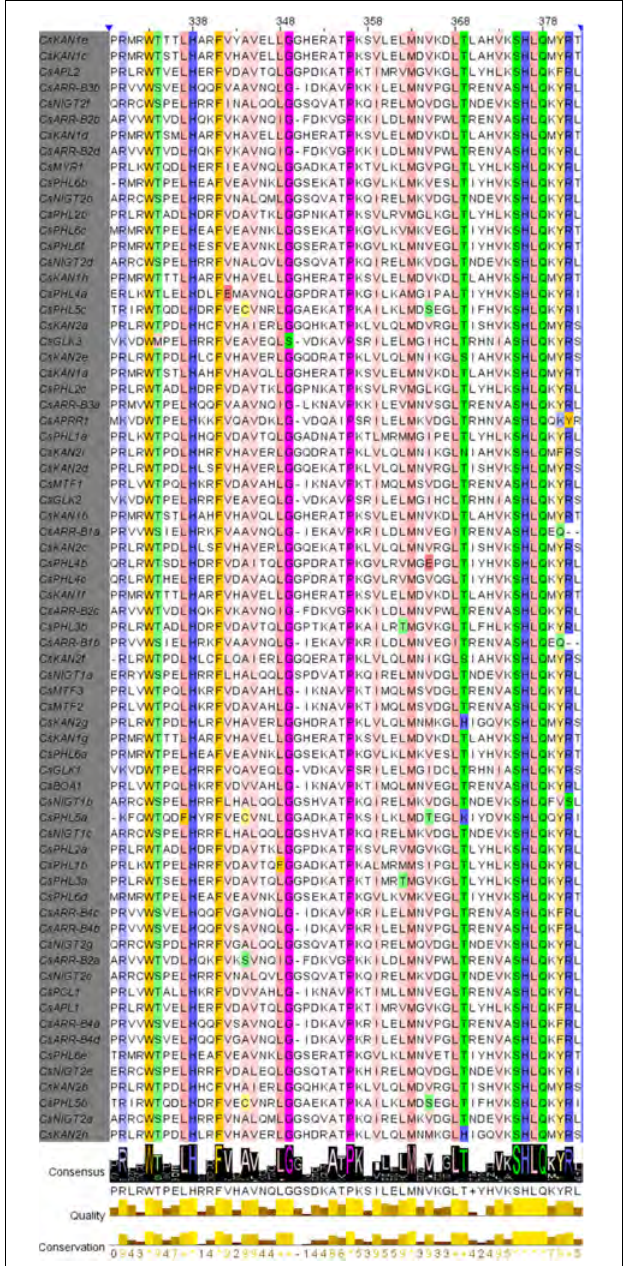
FIGURE 4 | Multiple sequence alignment of the B-motif of 69 CsGARP proteins. The conserved B-motif sequences of 69 CsGARPs were determined using ClustalX, and visual analysis was performed using